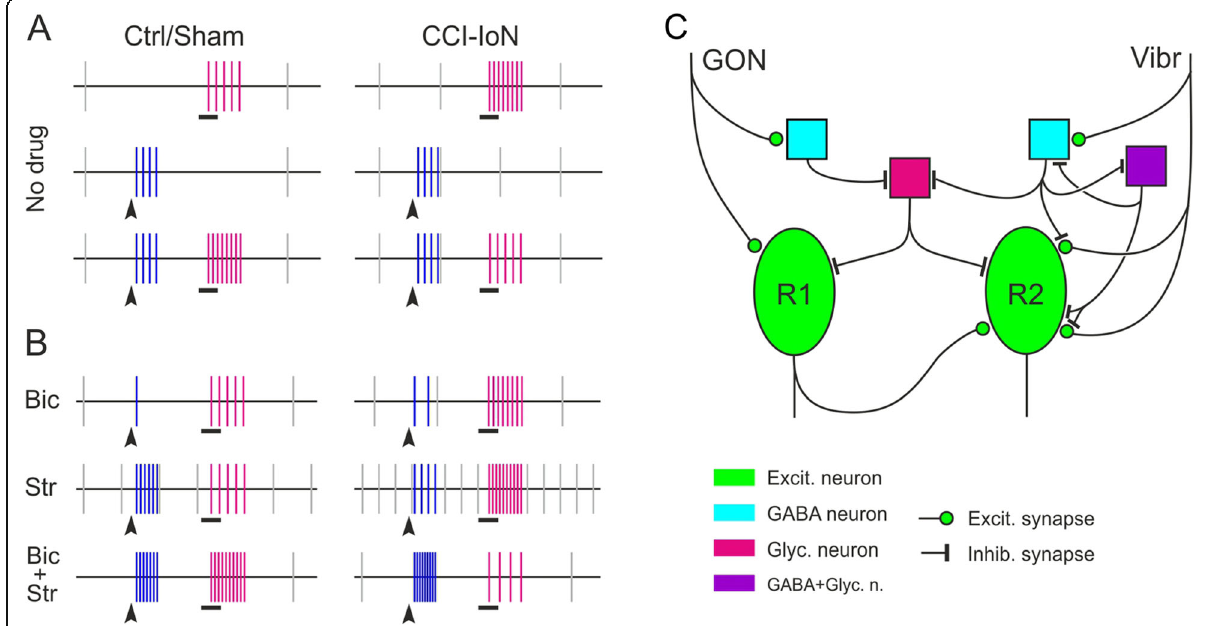
Fig. 7 ( a ) Simplified sketch of the neuronal discharges in TCC following vibrissal stimulation (black horizontal bars; magenta vertical bars) and GON stimulation (arrowheads; blue vertical bars). Gray vertical bars indicate the resting, spontaneous discharge of the same TCC units studied after vibrissal stimuli. For better visualization, spontaneous and evoked responses are represented at different time scales (spontaneous activity compressed 10x; interstimulus interval, stimulus duration and firing responses expanded 3-5x). The bottom recordings show the effect of a conditioning GON stimuli on the following response to facial stimuli. ( b ) Similar sketch summarizing the effects of blocking inhibitory GABAergic (Bic), Glycinergic (Str) or both GABA- and Glycinergic transmission (Bic + Str) on the conditioning effect of GON stimulation on the response to vibrissal stimulation. The number of vertical bars under each of these three conditions represent comparisons with the values observed just prior to the application of the drug(s) shown in ( a ). ( c ) Simplified view of a minimal local circuitry in laminae III of TCC that could help explain, at a circuital level only, the effects of GON stimulation on the successive response of TCC units to light stimulation of the vibrissal pad under control or CCI-IoN conditions. Units responding to GON could be different (R1, more likely) or the same (R2, less likely) units recorded after vibrissal stimulation. Color codes and geometric figures identify different excitatory and inhibitory neurons and synapses. Other possible excitatory neurons interposed in the circuit are